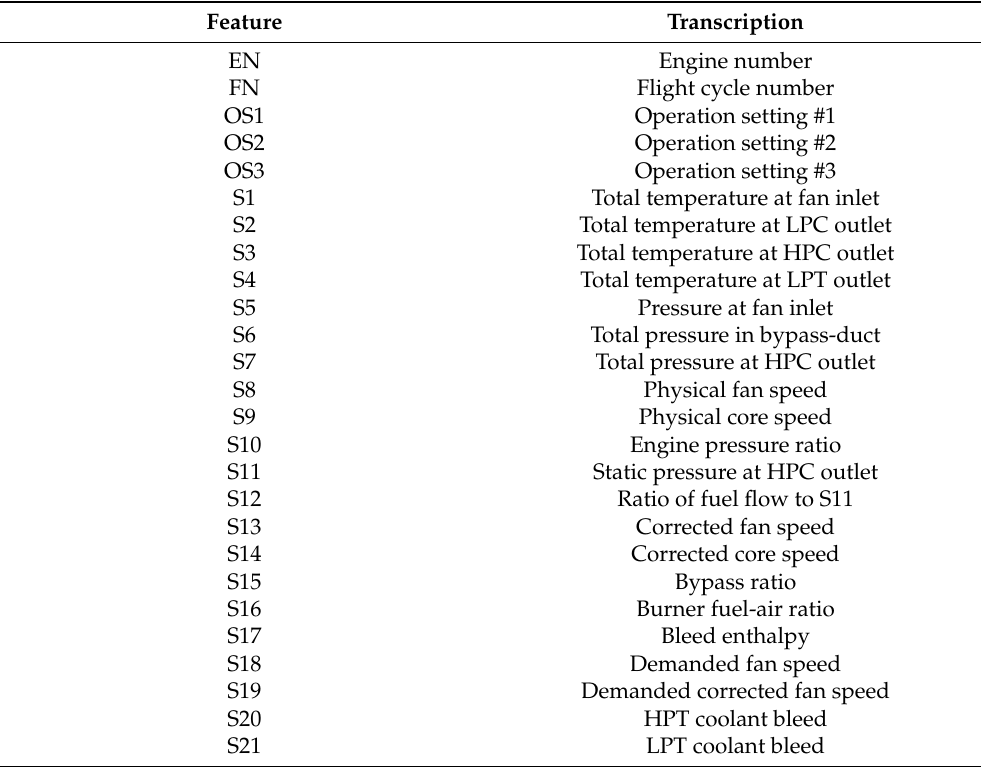
Table 2. Transcriptions of the features in the original data.